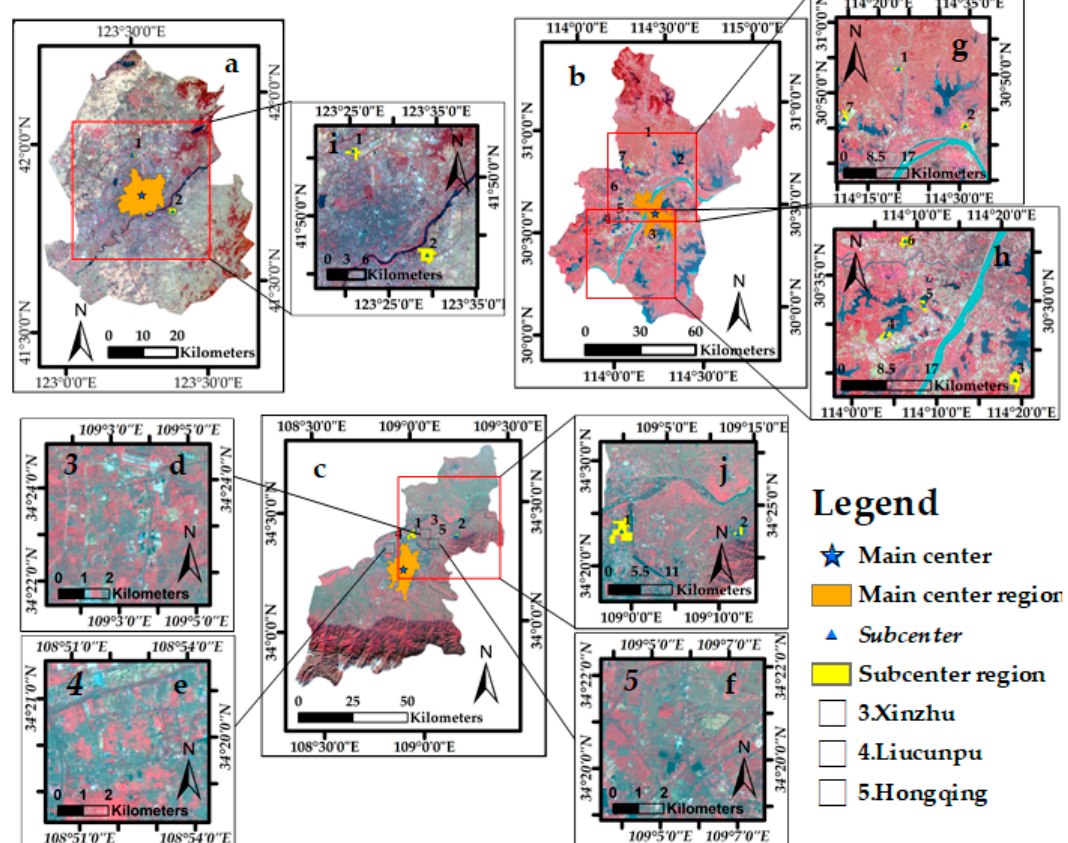
Figure 6. Polycentric structure. (a) Shenyang; (b) Wuhan; (c) Xi'an; (d) Xinzhu; (e) Liucunpu; and (f) Hongqing; (g) North and East; (h) South, Southwest and West;(i) Puhe and Hunhan; and (j) Lintong and Weiyang.